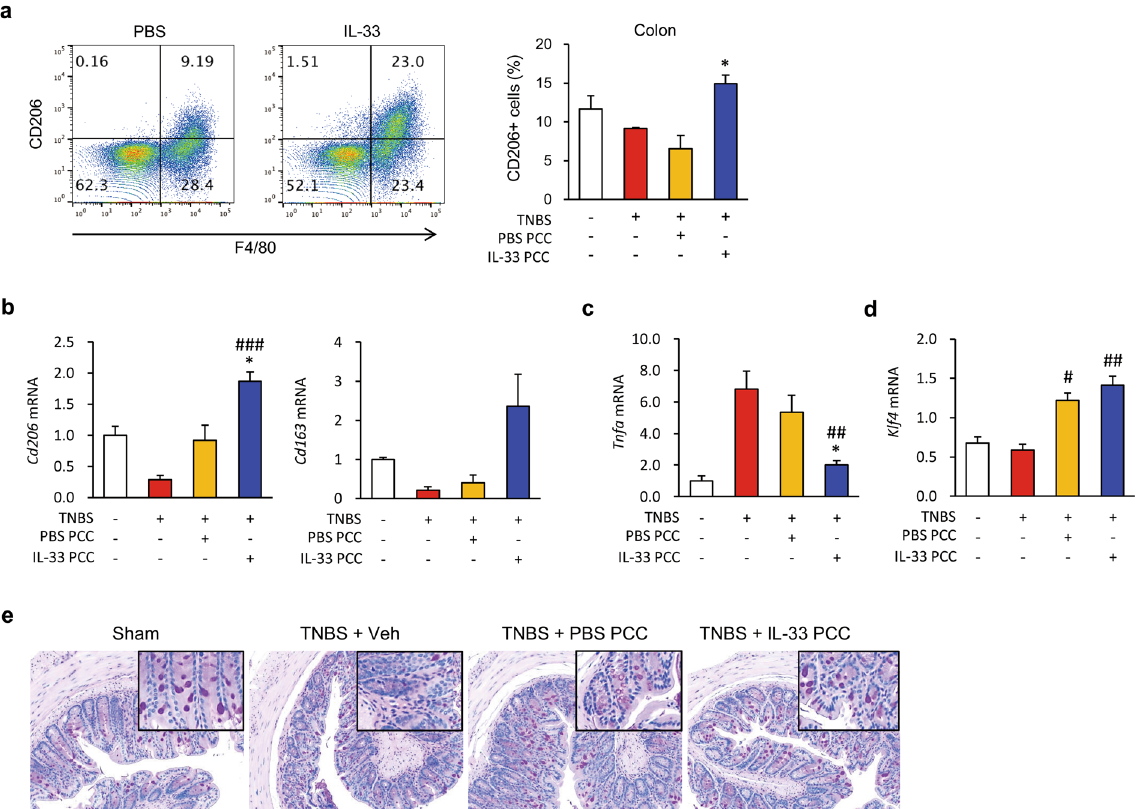
Figure 5. IL-33-treated peritoneal cavity cells rescue M2 macrophages and the goblet cells in colon tissues with colitis. ( a ) Representative flow cytometry plots of M2 (CD206 + ) macrophage (F4/80 + ) populations in colon samples. ( b – d ) Effects of IL-33 on the mRNA expression levels of M2 ( Cd206 and Cd163 , b ), M1 marker ( Tnfa , c ), and goblet cell marker ( Klf4 , D) in the colons. ( e ) Representative periodic acid-Schiff (PAS) staining of colonic mucosal samples. Original magnification: x200. Values are expressed as means (n = 5); error bars represent ± SDs. * P < 0.05 vs. PBS PCC as assessed by ANOVA. PCC, peritoneal cavity cell; Veh, injected with vehicle; IL-33, injected with mrIL-33; TNBS, injected with